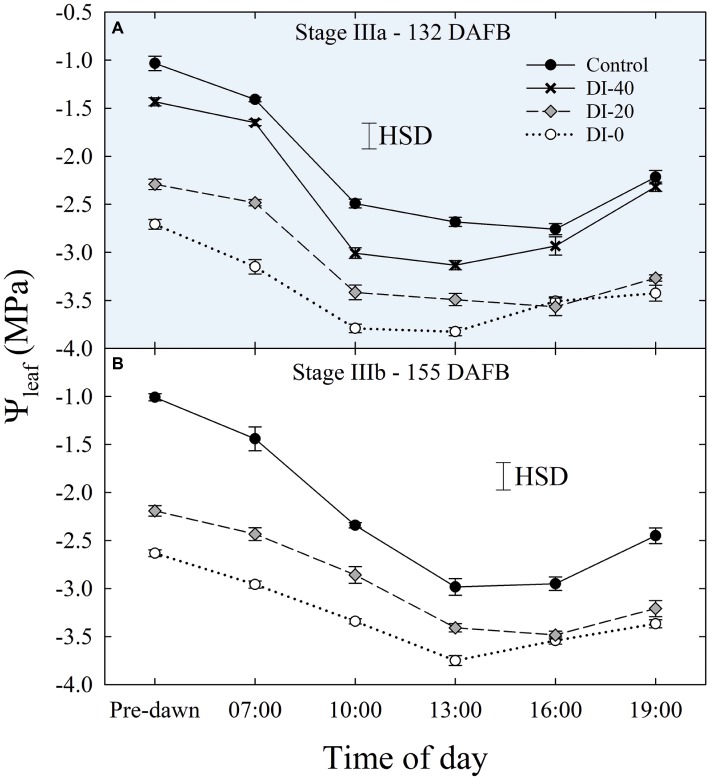
Daily curves of leaf water potential (Ψleaf) at stages IIIa (A) and IIIb (B) of ‘September Bright’ nectarine fruit growth. Trees irrigated to 100% (control), 40% (DI-40), 20% (DI-20), and 0% (DI-0) of crop evapotranspiration. Error bars represent standard errors of means (n = 6). Significant differences determined with analysis of variance and Tukey’s honestly significant difference (HSD, p < 0.05).